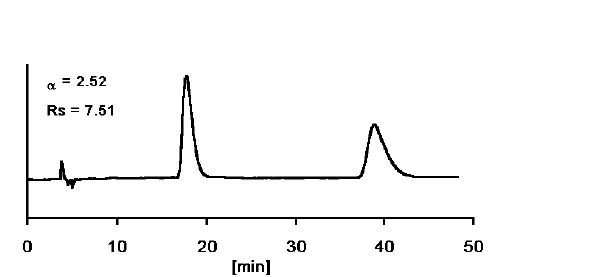
Figure 5. Enantioseparation of 11 (R = Me, X = H, n = 0) on Chiralcel OD-H